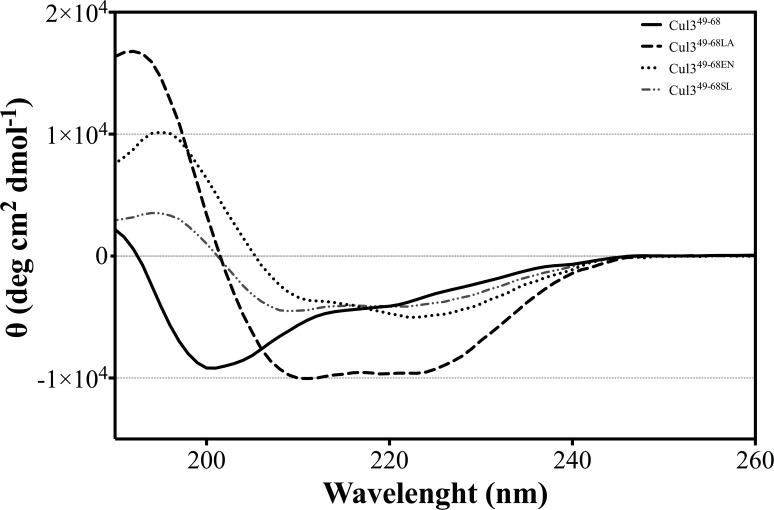
CD spectra.Far-UV CD spectra of Cul349-68, Cul349-68EN, Cul349-68LA, and Cul349-68SL. Spectra were acquired in 10 mM phosphate buffer pH 7.0.